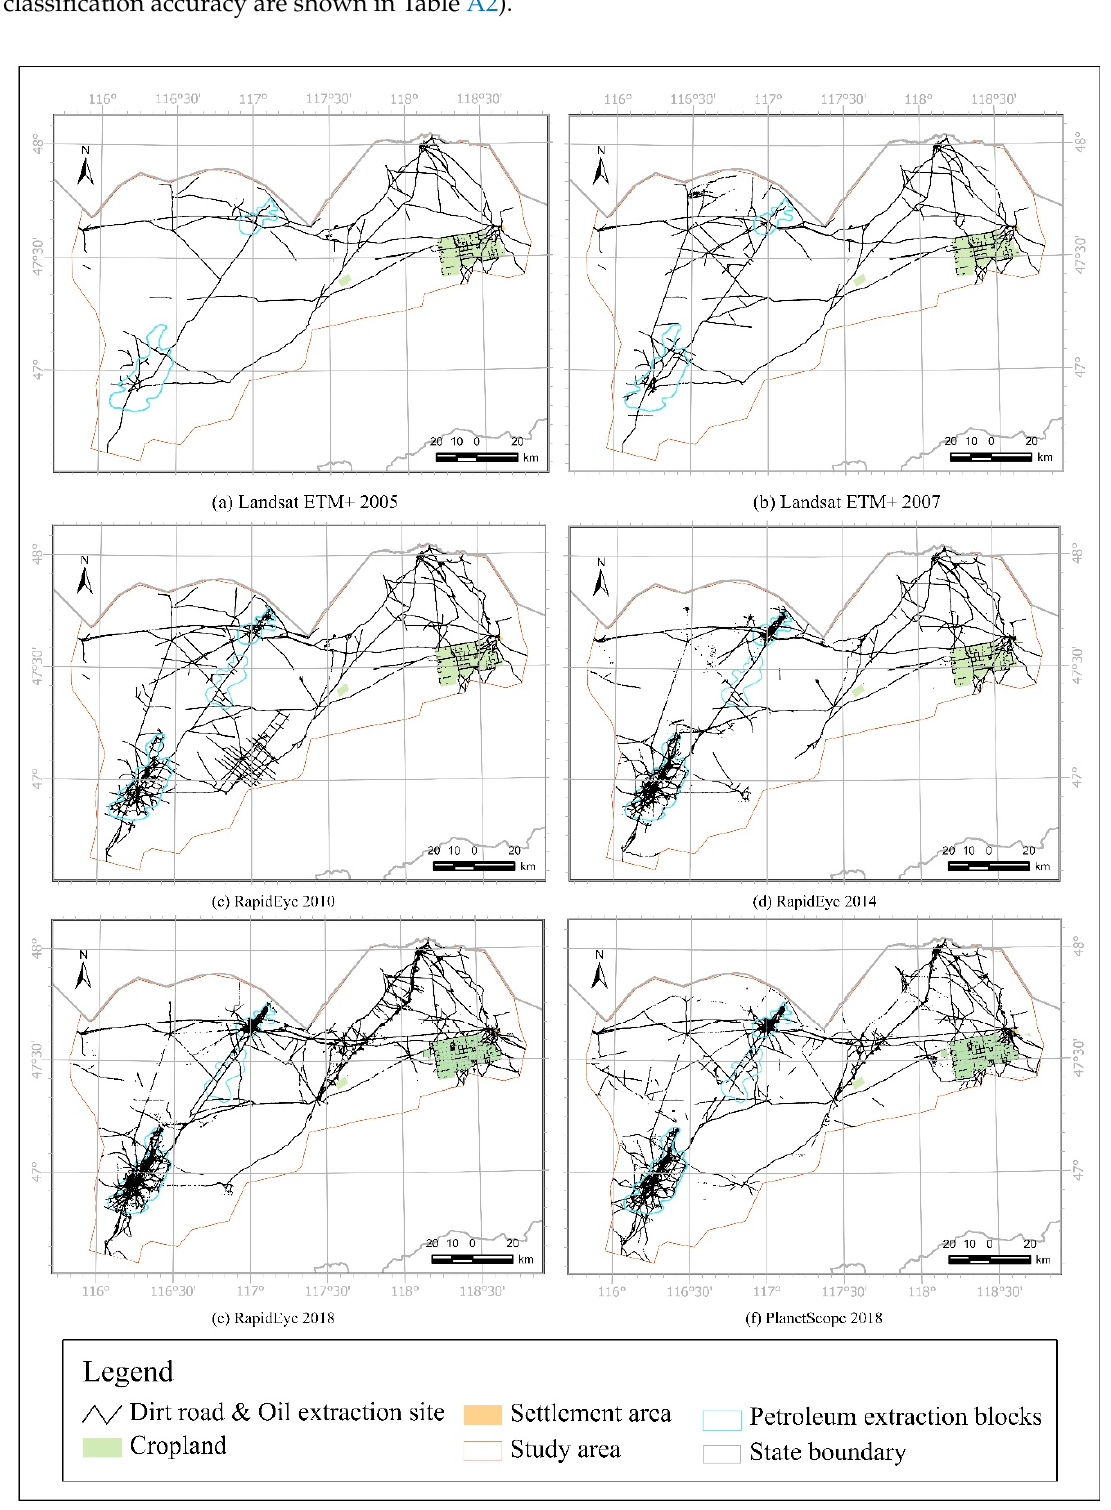
Figure 3. Classification results for expansion of dirt road and oil extraction infrastructure in 2005–2018: ( a – b ) Landsat ETM+ (15 m), ( c – e ) RapidEye (5 m), and ( f ) PlanetScope (3 m).